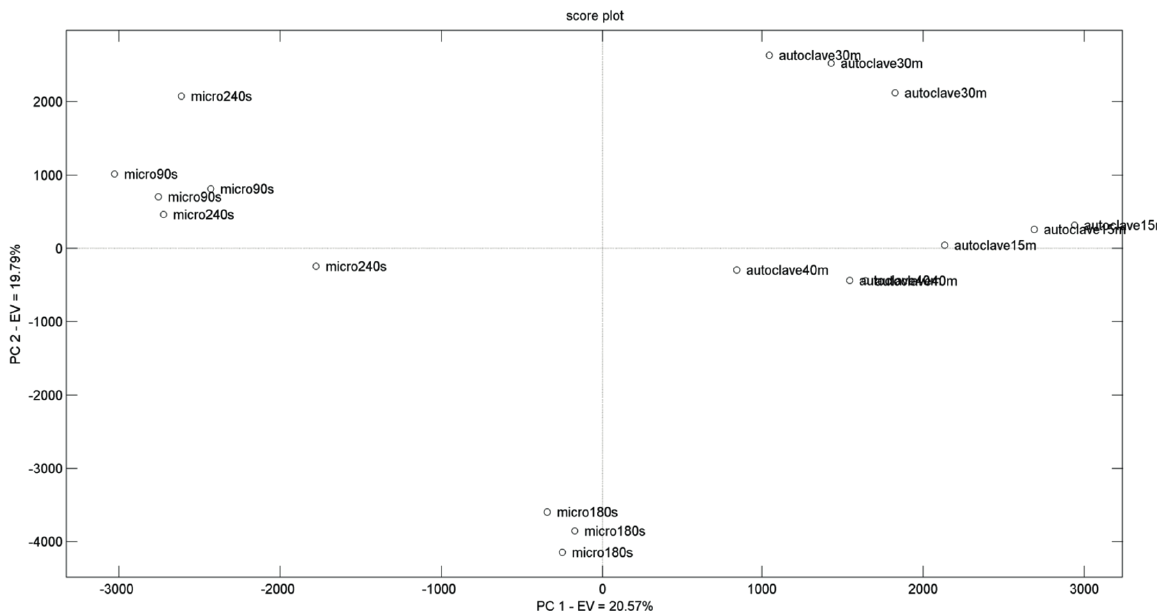
Figure 3. Score plot PCA1 x PCA2 of the sampled images. Micro90s, Micro180s, and Micro240s: agar made in a microwave for 90, 180, and 240 seconds, respectively. Autoclave15m, Autoclave30m, and Autoclave40m: agar made in a autoclave for 15, 30, and 40 minutes,